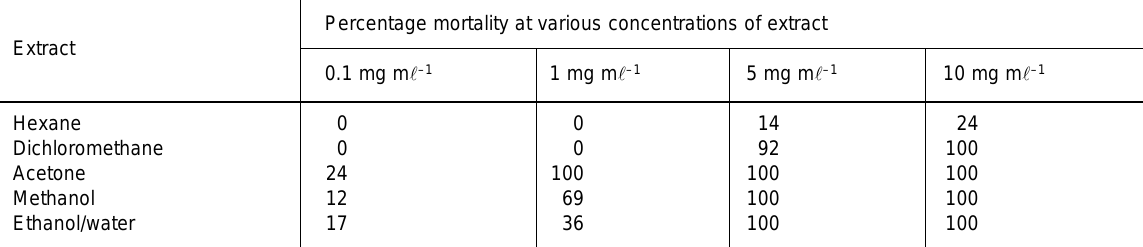
TABLE 2 Percentage mortality of Gunnera perpensa extracts against Artemia salina (brine shrimp) larvae Percentage mortality at various concentrations of extract